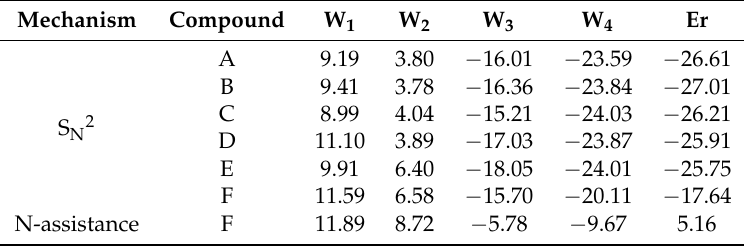
Table 2. Values of work done associated with each region (reactant (R), transition state (TS), and product (P)) in the reaction force (RF) profiles, given in kcal/mol. Er—reaction